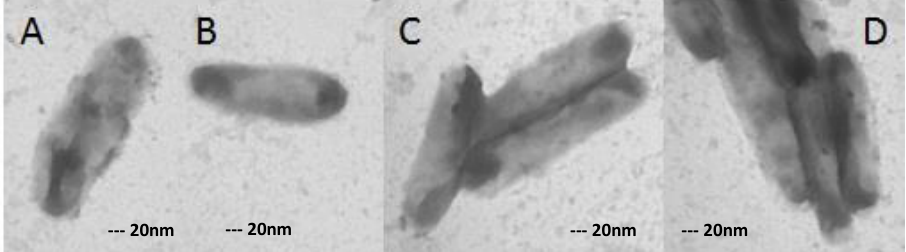
Figure 3. XDR-TB cells grown in medium containing 8 mg/L ofloxacin in single ( A and B ) and in flock ( C and D ). Magnification: 40,000 × .